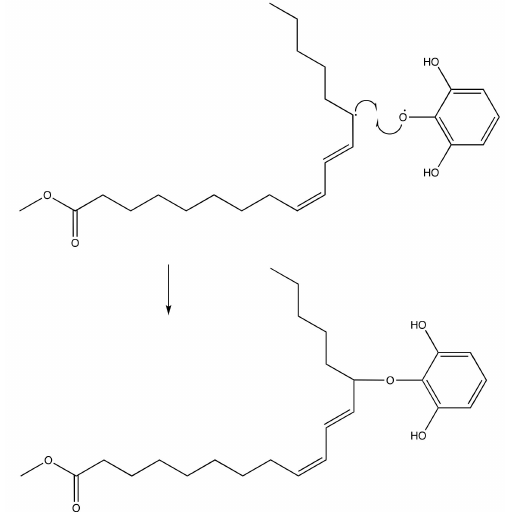
Figure 11. Radical termination mechanism of pyrogallol and methyl linoleate to form methyl (9 E ,11 E )-13-(2,6-dihydroxyphenoxy)octadeca-9,11-dienoate.